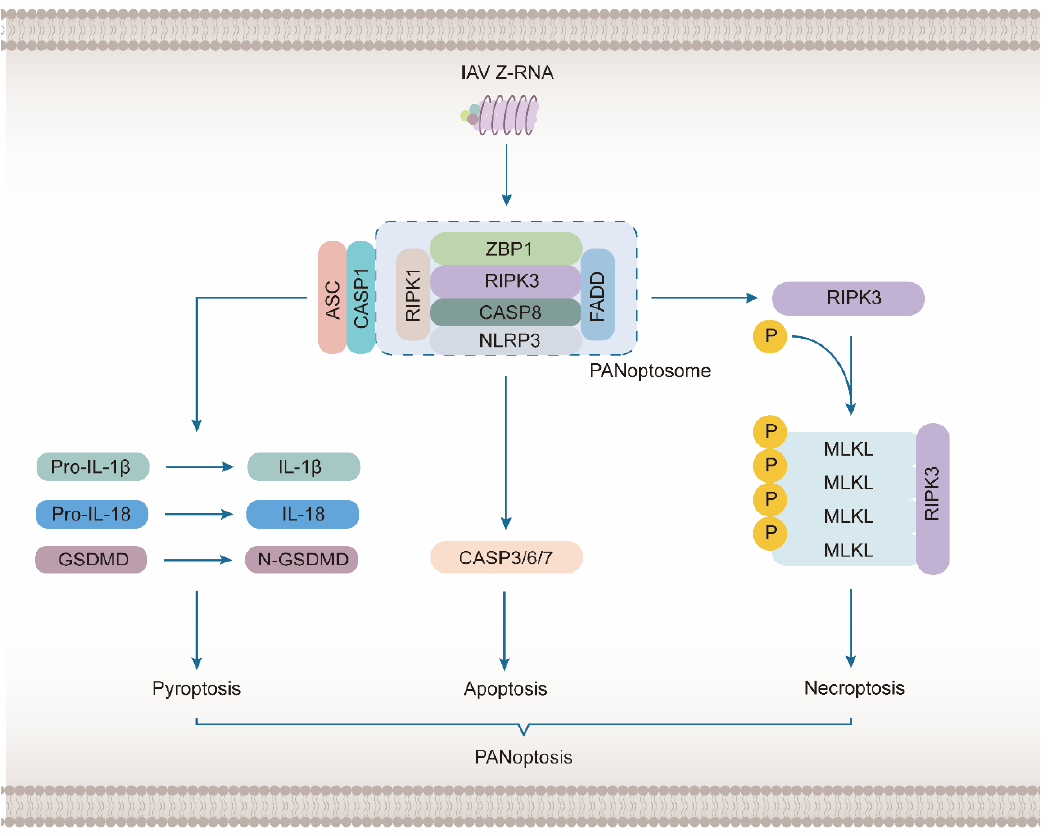
Figure 4. ZBP1 Induces PANoptosis following IAV Infection. PANoptosis represents a combination of pyroptosis, apoptosis, and necroptosis, which is mediated by ZBP1 following IAV infection and other viral infections and inflamma- tion. After sensing a large amount of IAV Z-RNA, ZBP1 can combine with RIPK1, RIPK3, Caspase-8, FADD, NLRP3, ASC, and Caspase-1 to form a giant complex called the PANopto- some. Among these molecules, RIPK1, RIPK3, FADD and caspase-8 are related to apoptosis. The activation of the molecules ultimately induces activation of caspase-8, which acts on the executor Caspase-3/6/7 and leads to apoptosis. While RIPK3 is mainly related to necroptosis, RIPK1 and FADD are also considered to play a positive role in the occurrence of necroptosis. The activation of RIPK3 directly activates and oligomerizes MLKL, the executor of necroptosis, to form an ion channel that destroys the plasma mem- brane. NLRP3, ASC, and Caspase-1 are key molecules in the occurrence of pyroptosis. They can form NLRP3 inflammasomes to promote the generation of final executors of pyroptosis. NLRP3 is responsible for sensing the corresponding stimulus. ASC has a PYD domain and a CEAD domain that can be recruited by NLRP3 and then recruit Caspase-1. Caspase-1 cleaves and activates the final executor, GSDMD. Pyroptosis is mainly caused by the N-terminal domain of GSDMD, which can transfer to the cell membrane and pro- mote pore formation, leading to the release of pro-inflammatory cytokines IL- 1 β and IL - 18. 4. The Role of ZBP1 in Human Diseases In human diseases caused by viruses, such as influenza and smallpox, ZBP1-medi- ated signal pathways control the programmed death of infected cells and related inflam- matory responses [37,102]. In addition, ZBP1 also plays an important role in regulating